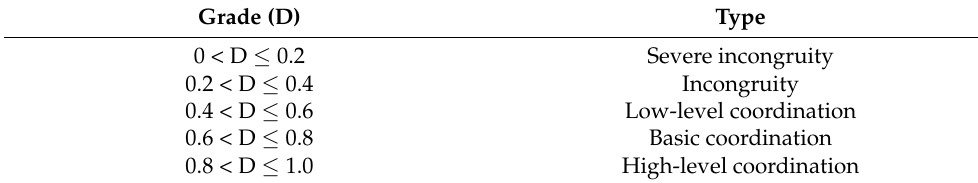
Table 2. Coupling coordination